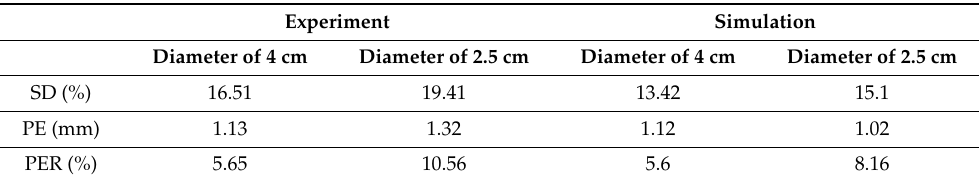
Table 1. Shape deformation (SD), position error (PE), and PE-to-radius ratio (PER) of the EIT images obtained with experiment and simulation, as shown in Figure 7.